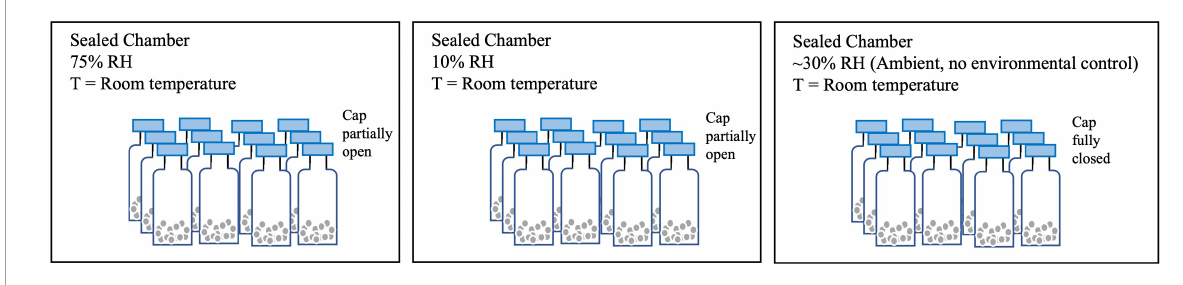
FIGURE1 The storage conditions for shelf-life